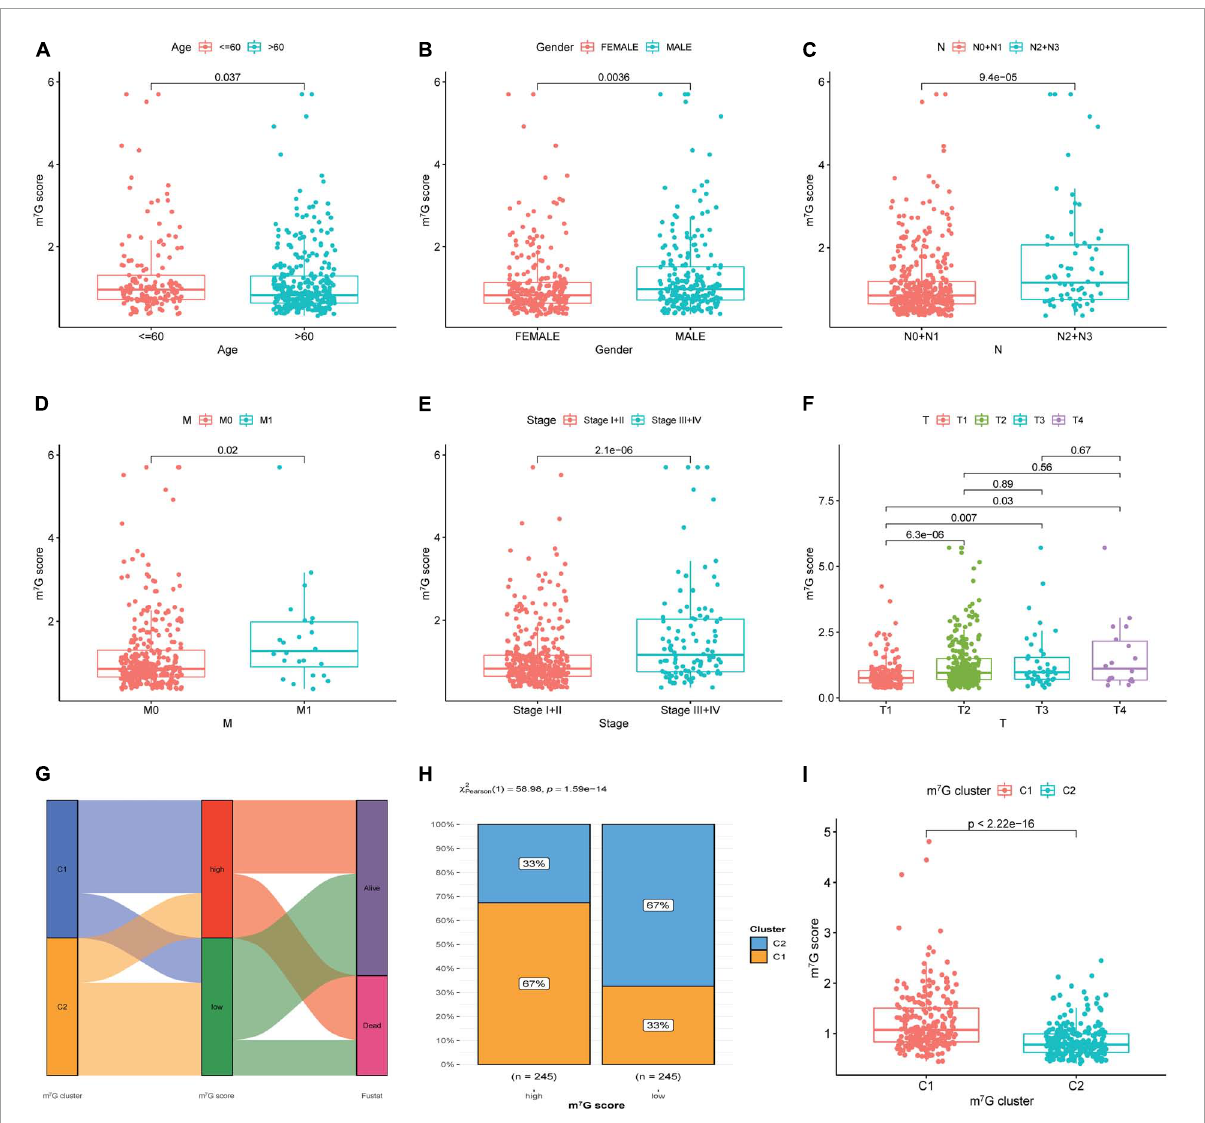
FIGURE8 Correlation among clinical features, molecular subtype and m 7 G score. (A–F) Correlation between clinical features and m 7 G score. (G) Relation between m 7 G score, m 7 G subtype and survival state by using Sankey diagram. (H) Distribution of m 7 G subtype between high and low m 7 G score groups. (I) Comparison of m 7 G score between C1 and C2